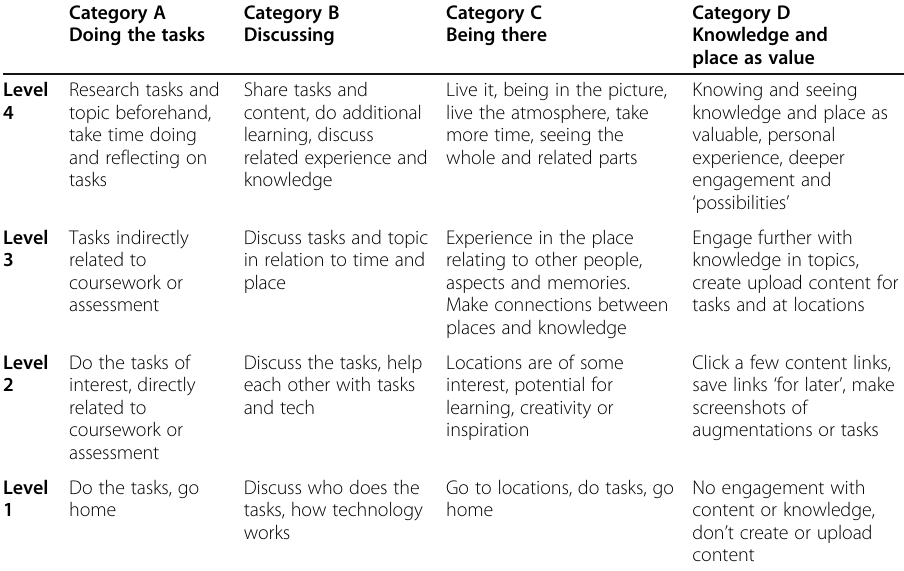
Table 1 The experience complexity of a smart learning journey (Lister,